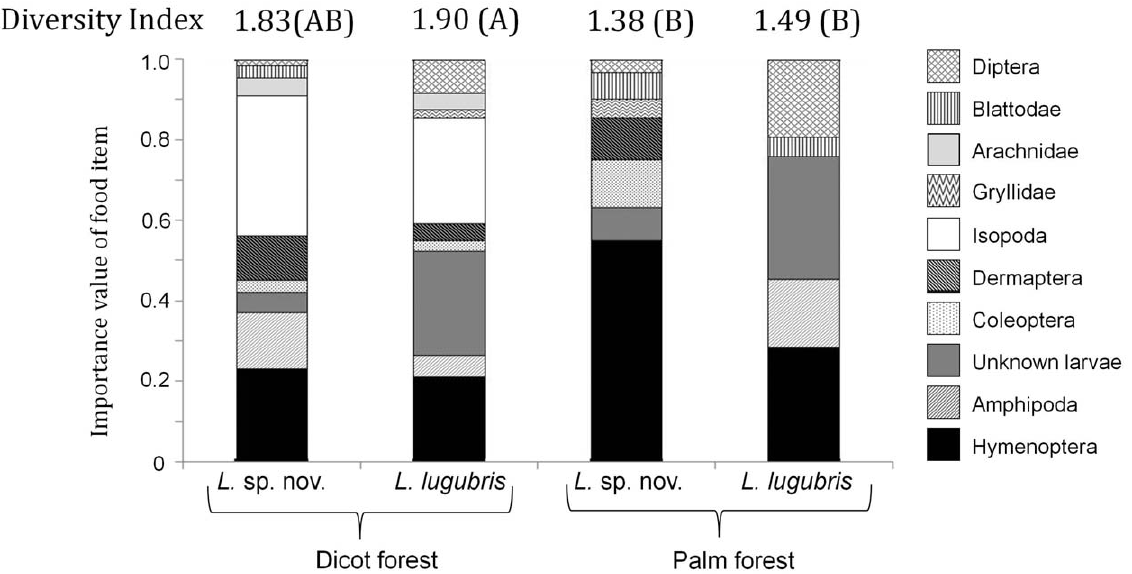
Figure 3. Mean number (A) and dry biomass (B) of invertebrate consumers ( + SE) found in pitfall traps placed on coast and interior of 4 islets of each forest type: dicot (black fill) and palm (no fill). Each sample is the average of three collections of an individual trap over 1 month; each collection was from a continuous 48 hour period. doi:10.1371/journal.pone.0041364.g003 PLOS ONE |